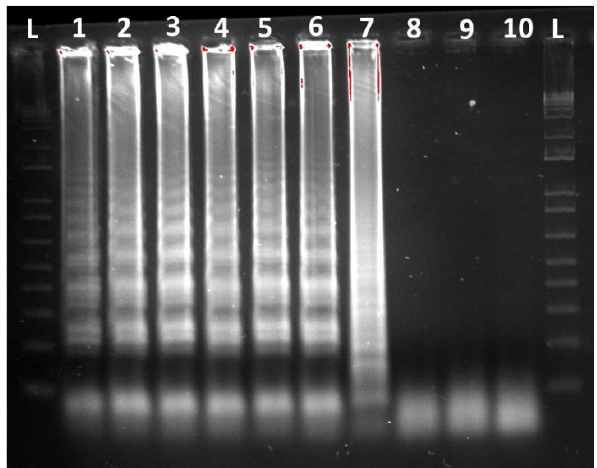
Figure 4. Analysis of the LAMP amplification products using gel electrophoresis. L lanes: 1 kb Plus DNA ladder. Lanes 1–8: amplification products from strain G. ( H.) parasuis DSM 21448 starting at concentrations of 10 ng/µL up to 1 fg/µL. Lane 9: DNA from Actinobacillus minor CCUG 38923 T . Lane 10: no template control.